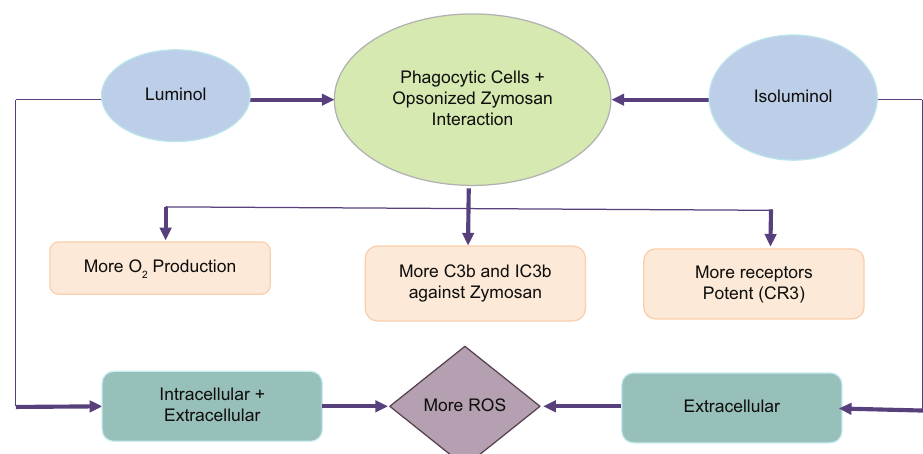
Figure-8: Schematic diagram of the reactive oxygen species production by camels’ phagocytic